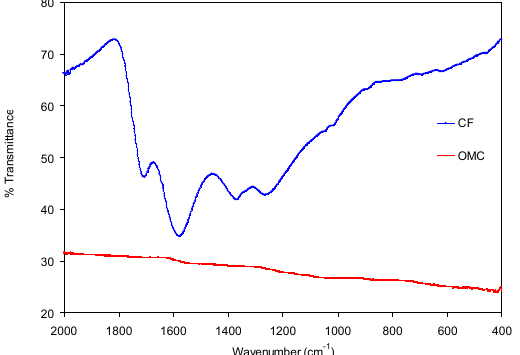
Figure 2. IR spectra of pristine CF and ordered mesoporous carbon